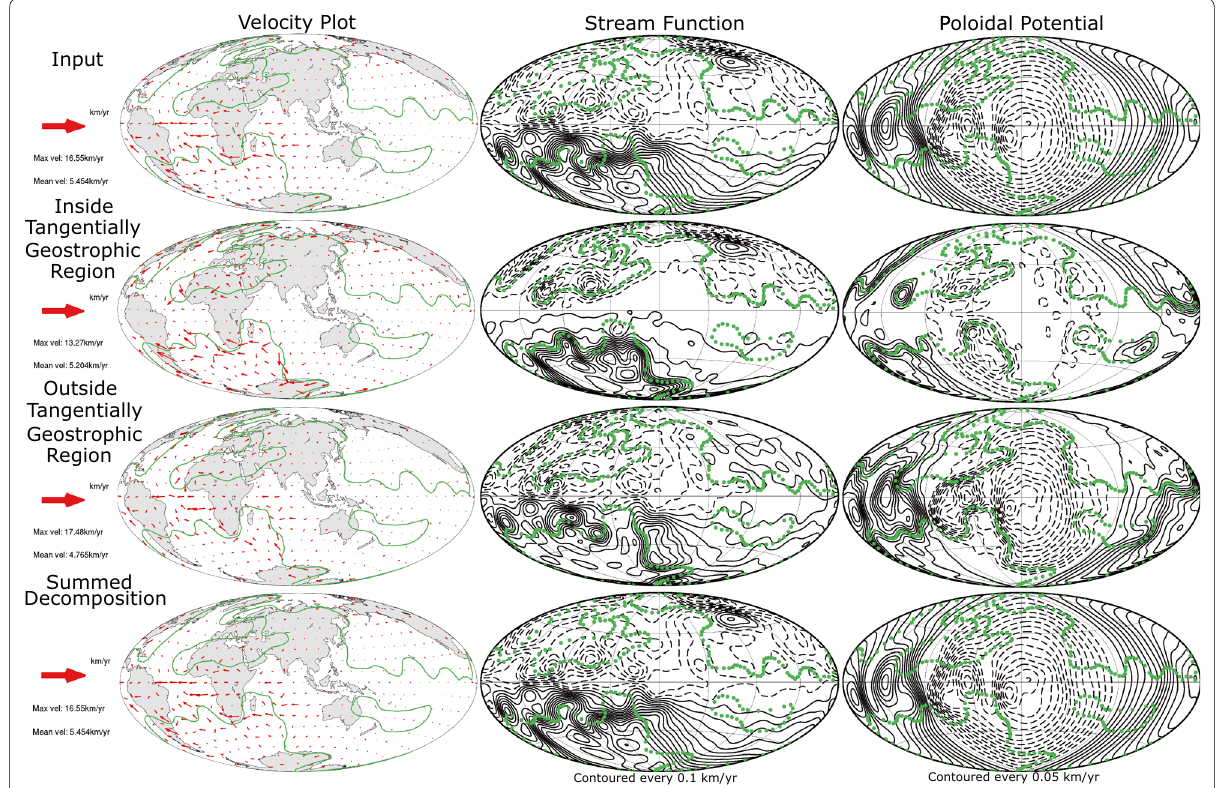
Contoured every 0.05 km/yr Fig. 11 Decomposition of inverted flow from satellite data plotted as velocity vectors, stream function and poloidal potential. A decomposition of the toroidal and poloidal components of the inverted flow from satellite data, seen in Figs. 7 and 8, as velocity (column one), stream function (column two) and poloidal potential (third column). The input, top row, is split into inside and outside the tangentially geostrophic ambiguous patches, rows two and three, before being summed together in the final row. As with previous decompositions, the input and the summed decomposition are identical and flow is mostly restricted to the region of interest with the decomposed